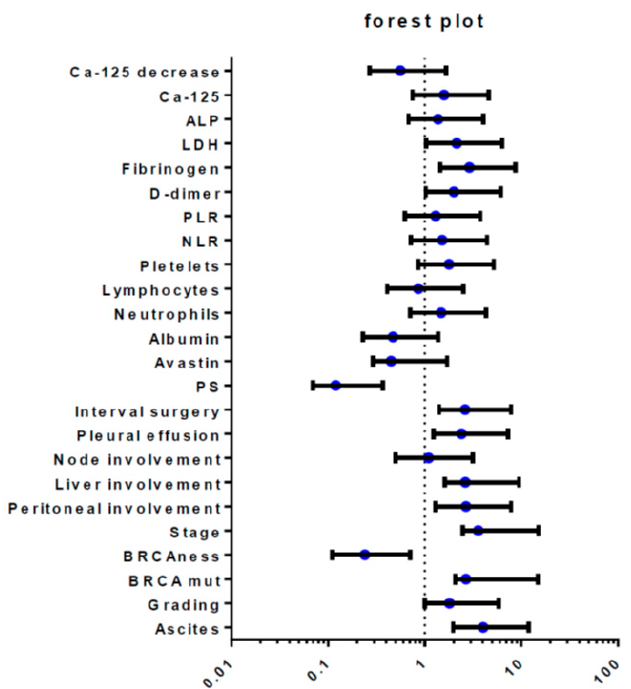
Figure 1. Forest Plot, major prognostic factors; Figure shows the effect of univariate analysis for each prognostic factor by log rank test for each variable, reported with appropriate confidence interval.